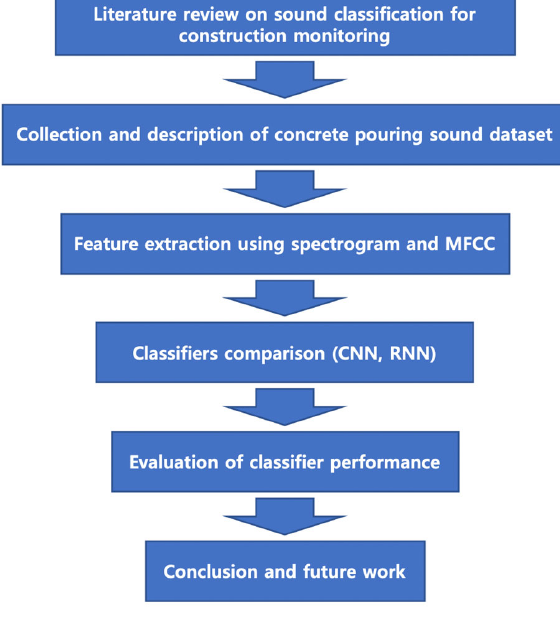
Figure 1. Research Figure 1. Research process.